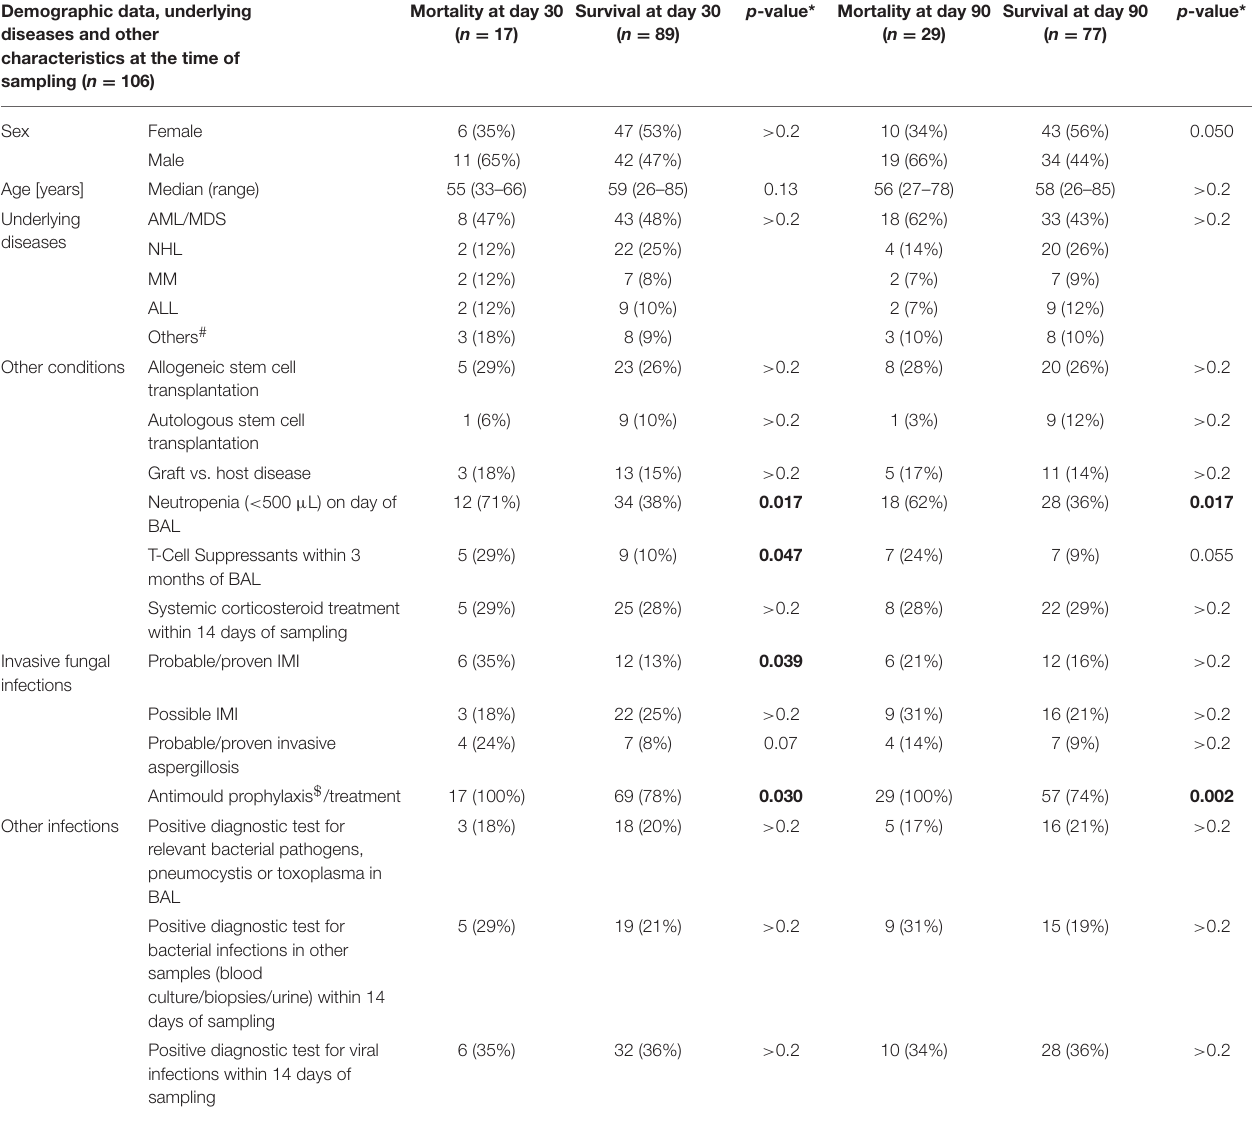
TABLE 1 | Demographic data, underlying diseases, and infections in cases who died within 30 and 90 days after bronchoscopy vs. those who survived. Demographic data, underlying diseases and other characteristics at the time of sampling ( n =